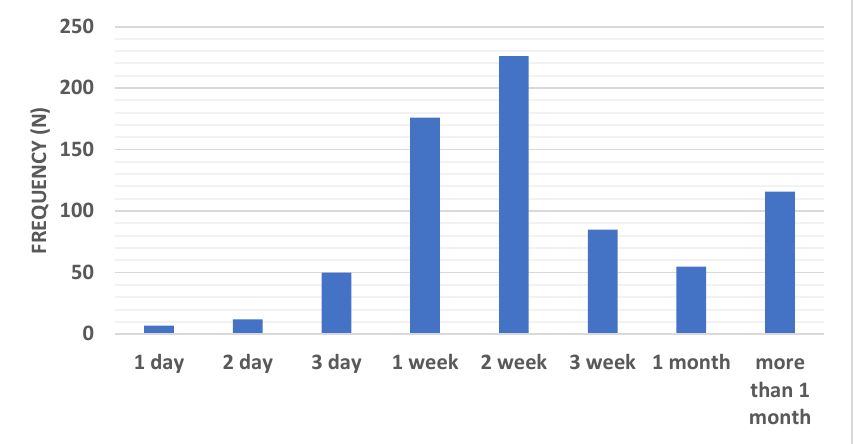
Figure 3. Distribution of recovery periods recorded among the COVID-19 group. Data were presented as frequency (number).